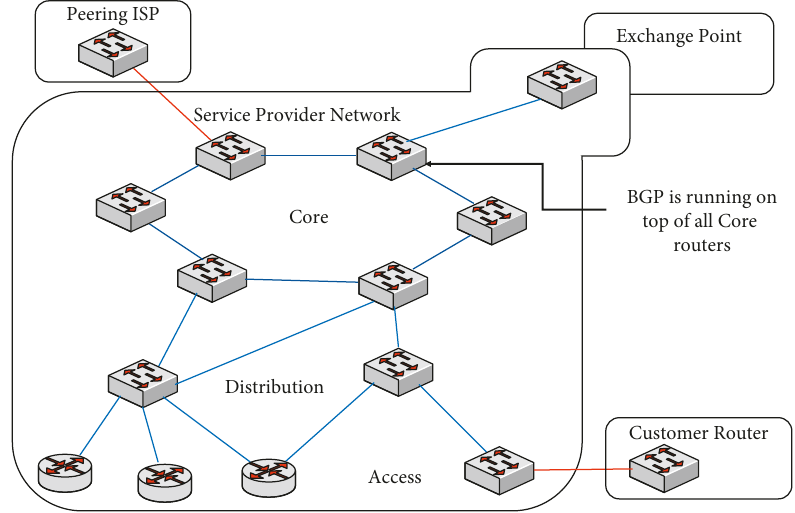
Figure 12: BGP-4 as a hybrid controller protocol for SDN